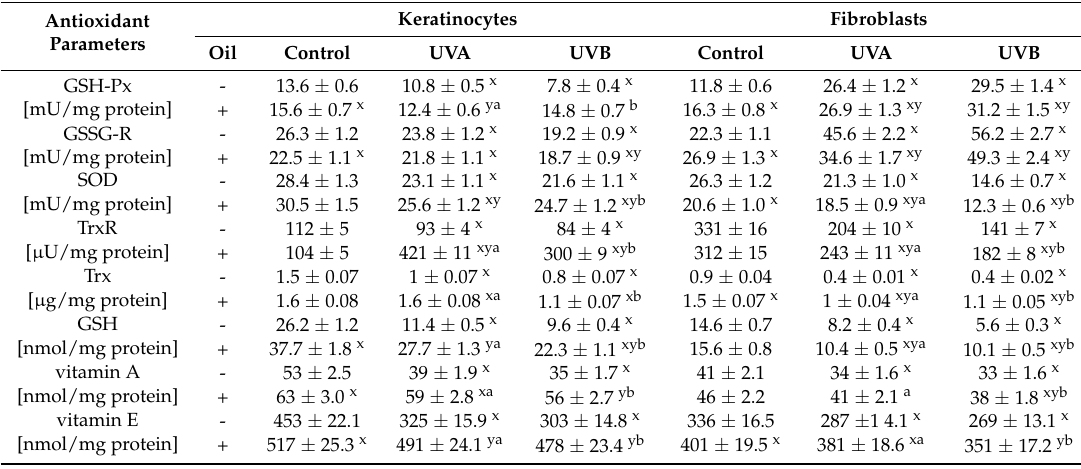
Table 3. The activity of antioxidant enzymes (GSH-Px, GSSG-R, SOD, TrxR) and the level of non-enzymatic antioxidants (GSH, Trx, vitamins A, E, and C) in keratinocytes and fibroblasts after exposure to UVA (30 J/cm 2 and 20 J/cm 2 ) and UVB radiation (60 mJ/cm 2 and 200 mJ/cm 2 , respectively) and sea buckthorn seeds oil (500 ng/mL)